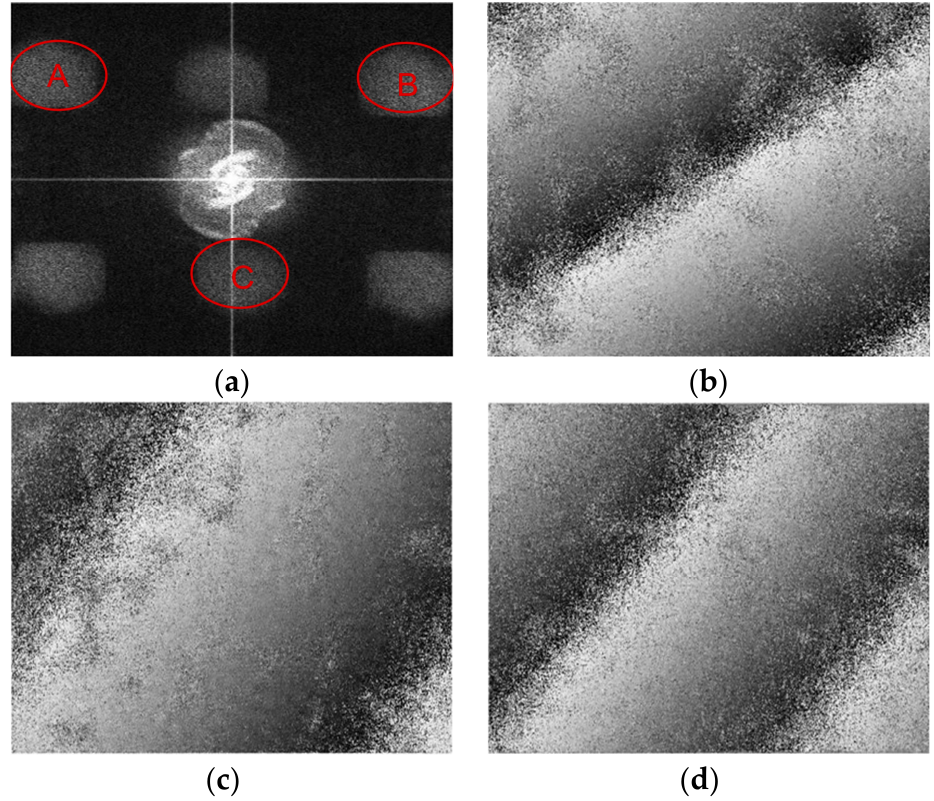
Figure 4. Frequency spectrum and phase maps: ( a ) spectrum obtained after Fourier transform; ( b ) wrapped phase map corresponding to frequency component A; ( c ) wrapped phase map corresponding to frequency component B; ( d ) wrapped phase map corresponding to frequency component C.